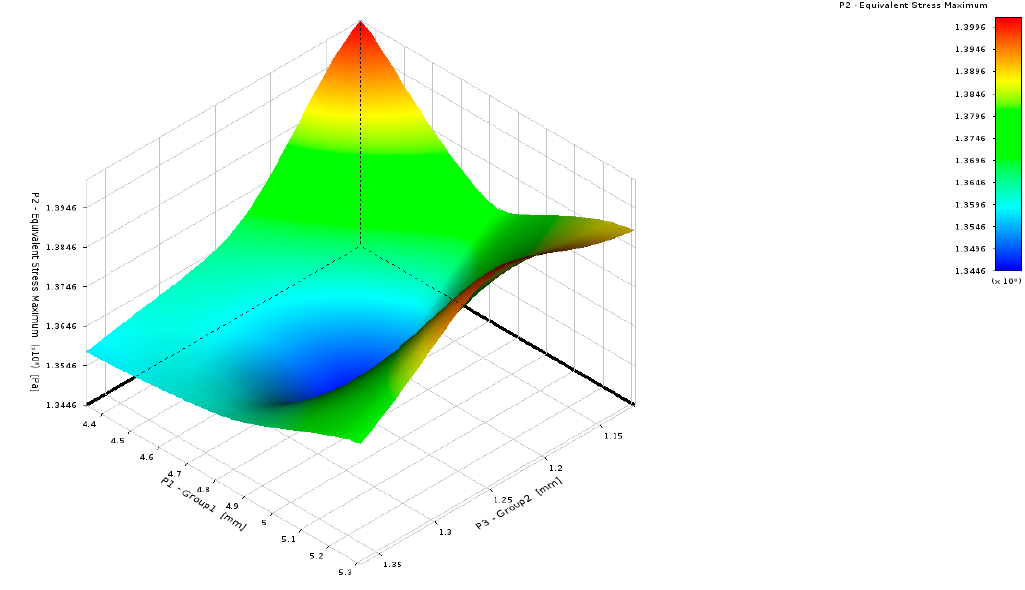
Figure 17. Response surface optimization Figure 17 . Response surface optimization result. Figure 17 . Response surface optimization result.